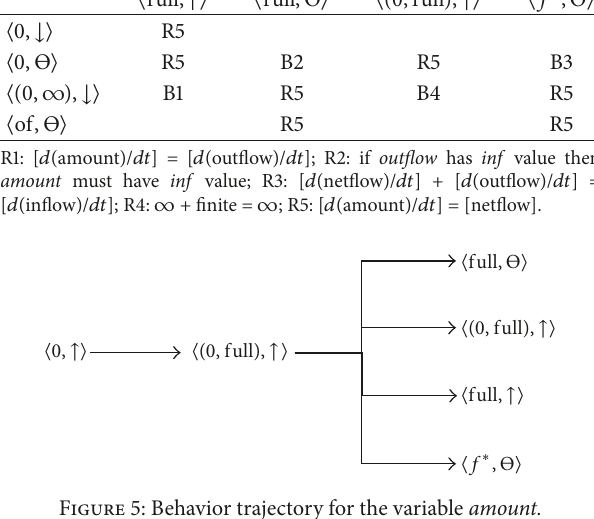
Table 7: Filtering behaviors using Deriv (amount, netflow). Netflow